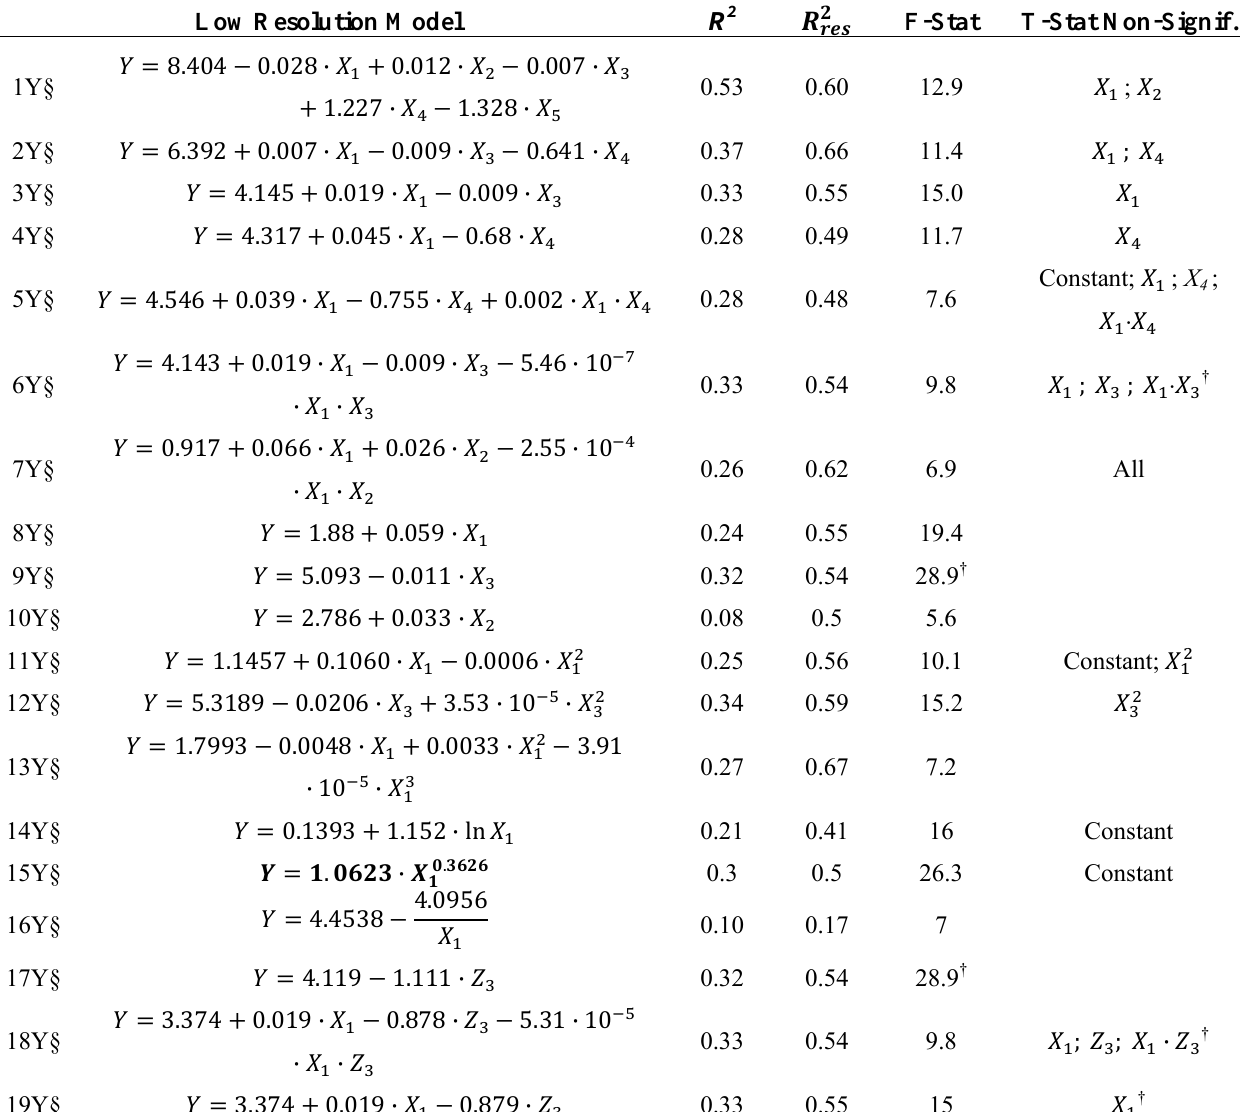
Table 10. Summary table for yield prediction models adapted to low resolution maps. Low Resolution